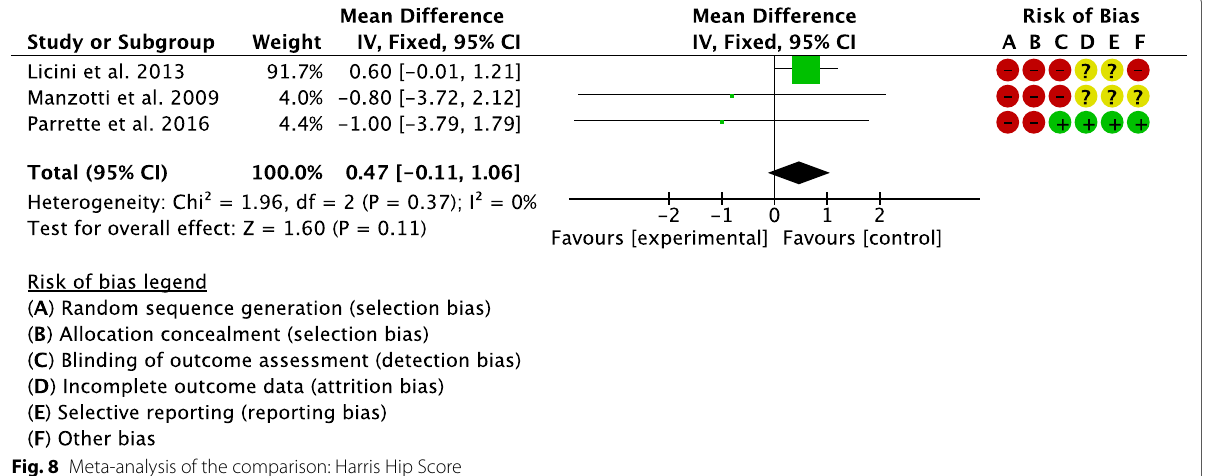
Fig. 8 Meta-analysis of the comparison: Harris Hip Score